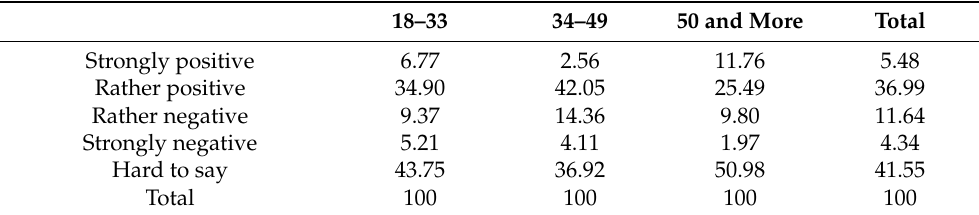
Table 12. Declared attitudes towards automation in the workplace versus age in % (N = 438).